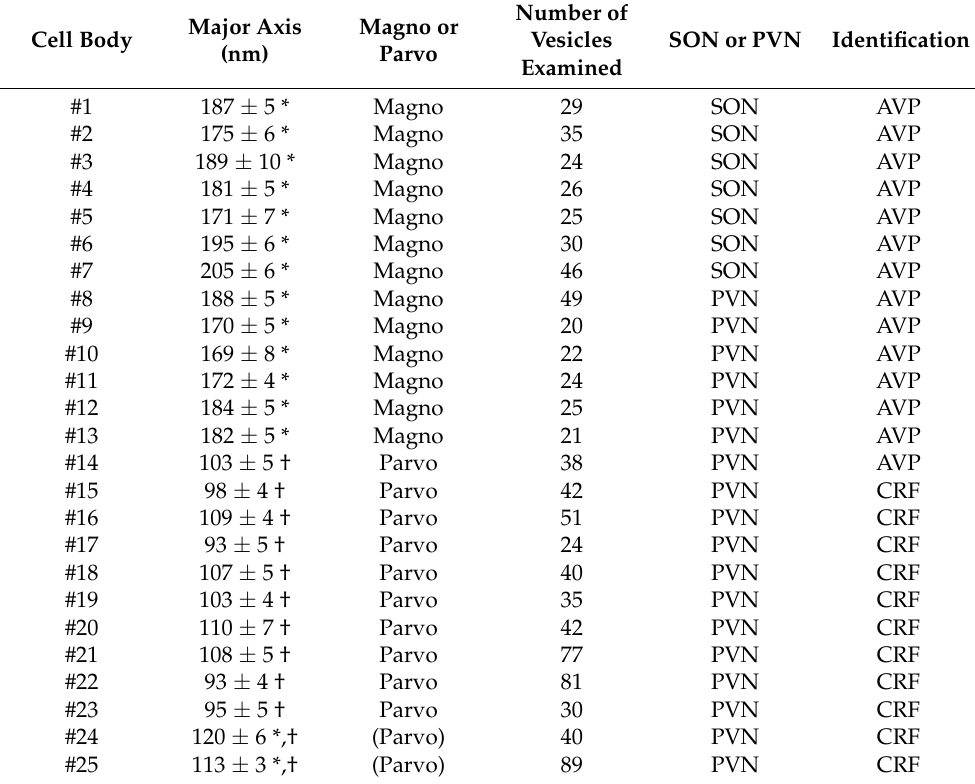
Figure 6. Double-label immunoelectron microscopy for vasopressin-associated neurophysin (NPII) and copeptin in the macaque supraoptic nucleus (SON). Many dense-cored neurosecretory vesicles located in the cell body were doubly immunopositive for copeptin (10-nm gold particles) and NPII (15-nm gold particles). The outlined area in ( A ) is enlarged in ( B ). Scale bars, 200 nm, and 100 nm in the enlarged image. Arrows indicate dense-cored neurosecretory vesicles. m, mitochondrion. Table 3. Characterization of cell types (magno- or parvocellular neurons) based on the major axis of dense-cored neurosecretory